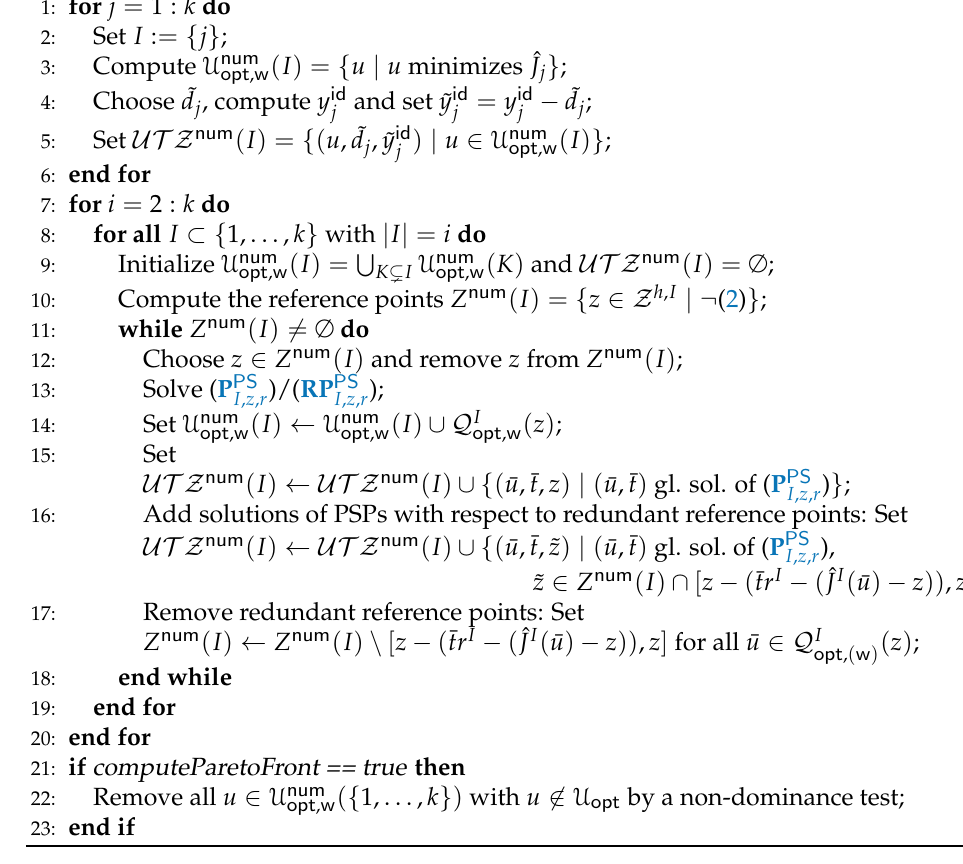
Algorithm 1 Solving ( MOP ) numerically by the hierarchical PS